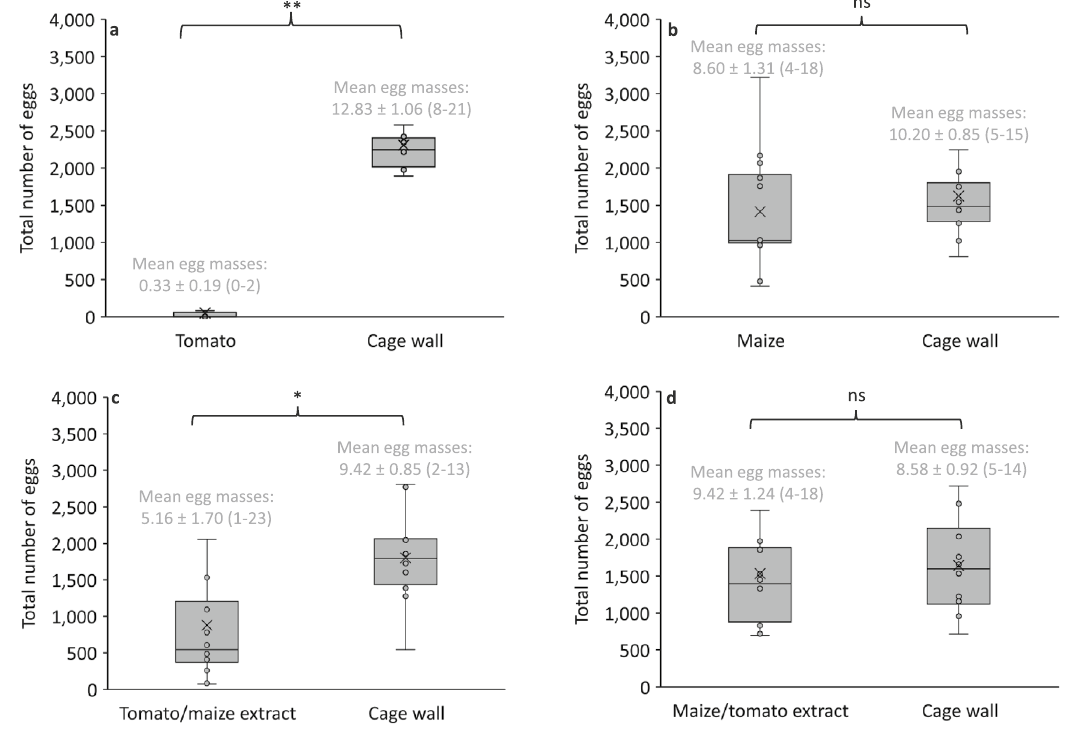
Figure 1. Total number of eggs and egg masses (mean ± SD, min.-max. range) of the fall armyworm, Spodoptera frugiperda recorded under a no-choice experiment arena and using ( a ) tomato, ( b ) maize, ( c ) tomato sprayed with maize extract, and ( d ) maize sprayed with tomato extract. Statistical differences based on t-test for the occurrence of egg masses in the plants vs. oviposition observed in the net walls. Statistics for total number of eggs: Tomato (t = 17.02, 11 df, P < 0.001); Maize (t = 0.63, 11 df, P = 0.2697); tomato with maize leaf extract (t = 2.71, 11 df, P = 0.01); Maize with tomato leaf extract (t = 0.31, 11 df, P = 0.378); and for egg masses: Tomato